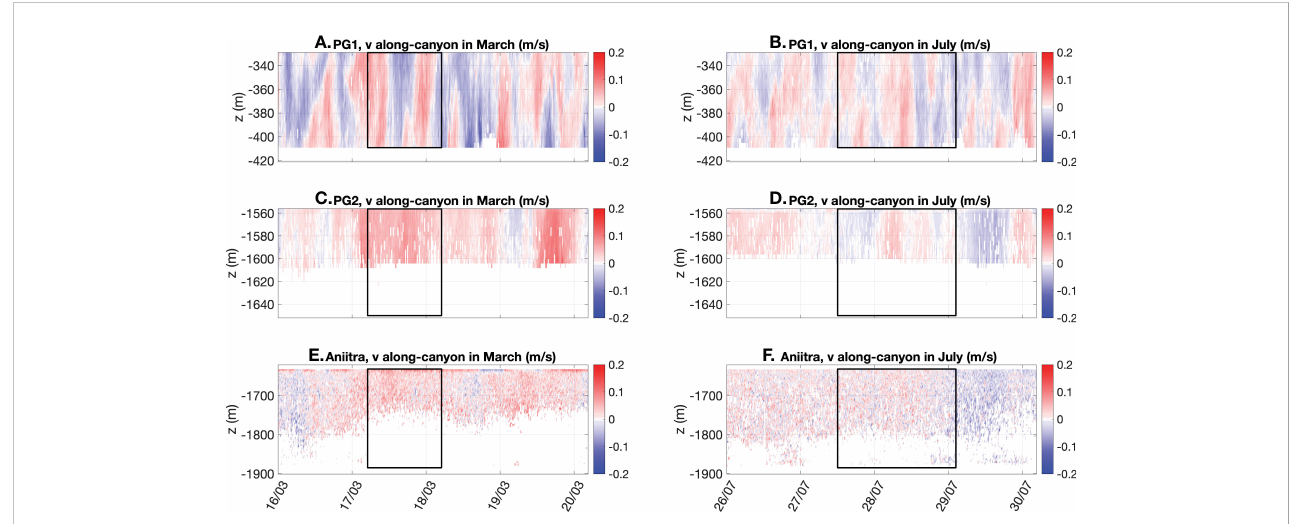
FIGURE 8 Along-canyon current (m s – 1 ) measured by the PG1 mooring: (A) in March and (B) in July. Along-canyon current (m s) measured by the PG2 mooring: (C) in March and (D) in July. Along-canyon current (m s – 1 ) measured by the Aniitra mooring: (E) in March and (F) in July. The boxes indicate upwelling events.